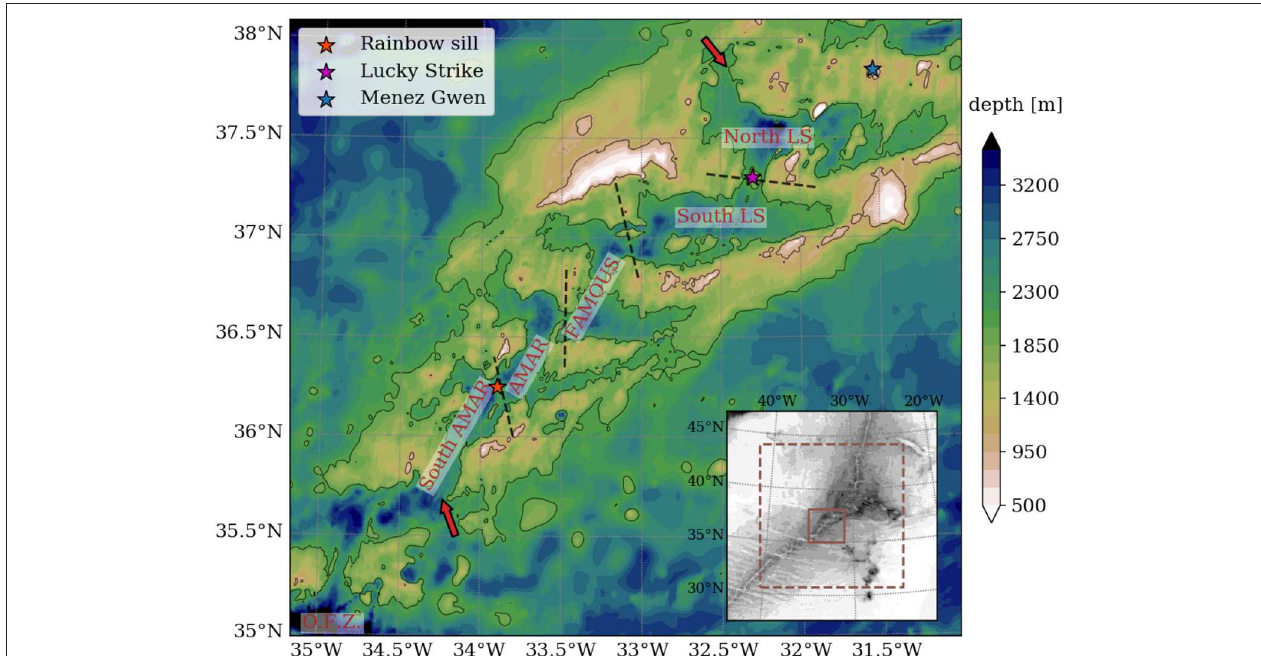
FIGURE 1 | Bathymetry of the North Mid-Atlantic Ridge in the region discussed in this paper (taken from the SRTM30plus database). Black contours indicate iso-depth at 2,000 and 1,000 m. Dashed lines delimitate basins and segments of interest (written in brown). These are usually associated with fracture zones aligned along the West-East direction. The rift valley water is mostly isolated below 2,000 m, except at a few locations: red arrows indicate identified connections (inflows) from the exterior ridge flanks to the inside valley at some of these passages. O.F.Z., Oceanographer Fracture Zone. et al., 2008) surveys. All CTD data were processed with